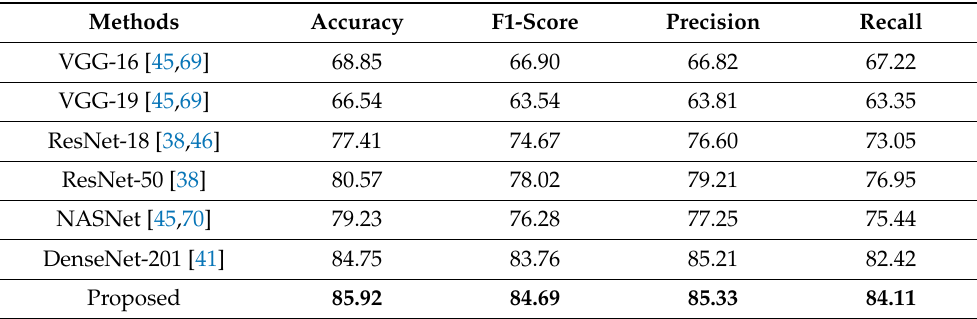
Table 13. Performance comparisons of the state-of-the-art methods and proposed approach with RIA. Averages from a 10-fold cross-validation are shown (unit: %). Methods